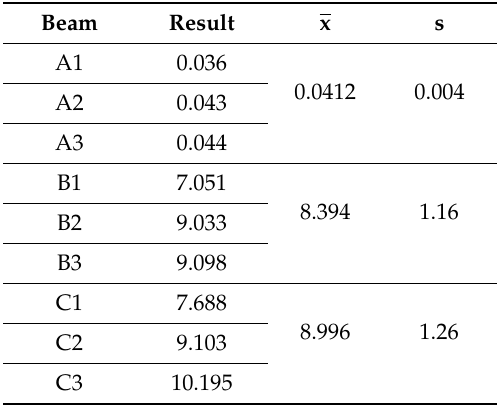
Table 4. HSC and SFRHSC beams fracture energy results along with the arithmetic mean (x) and standard deviation (s) for each series (kNm / m 2